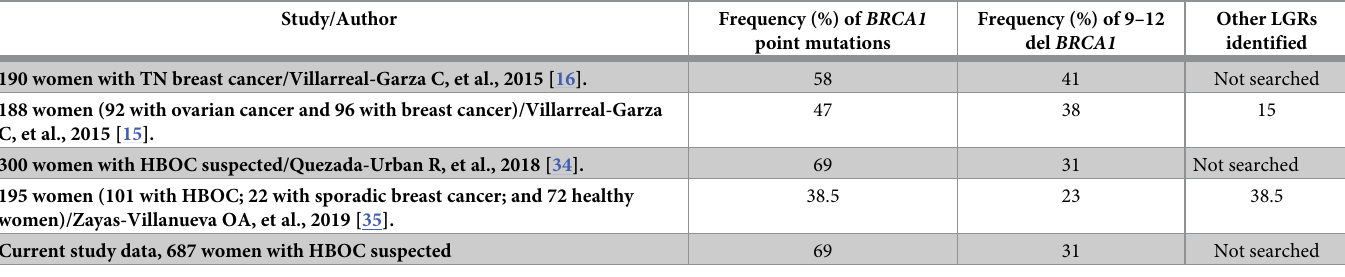
Table 2. Frequency of BRCA1 mutations in Mexican population: Proportion representing 9–12 del BRCA1 .